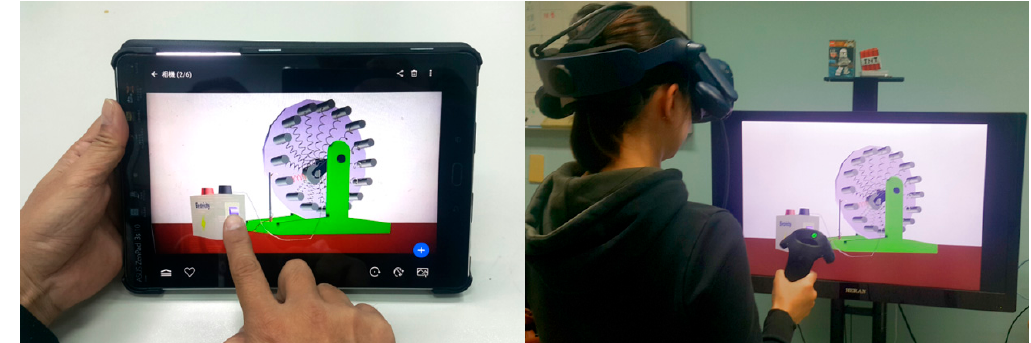
Figure 7. Conducting the virtual experiment using a mobile or head-mounted device.